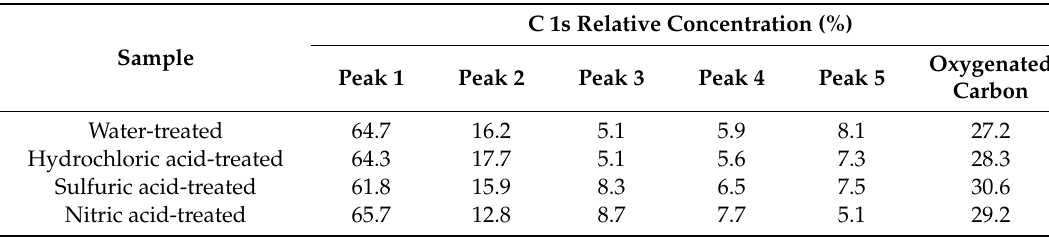
Table 4. Relative concentration of different groups in C 1s peak.